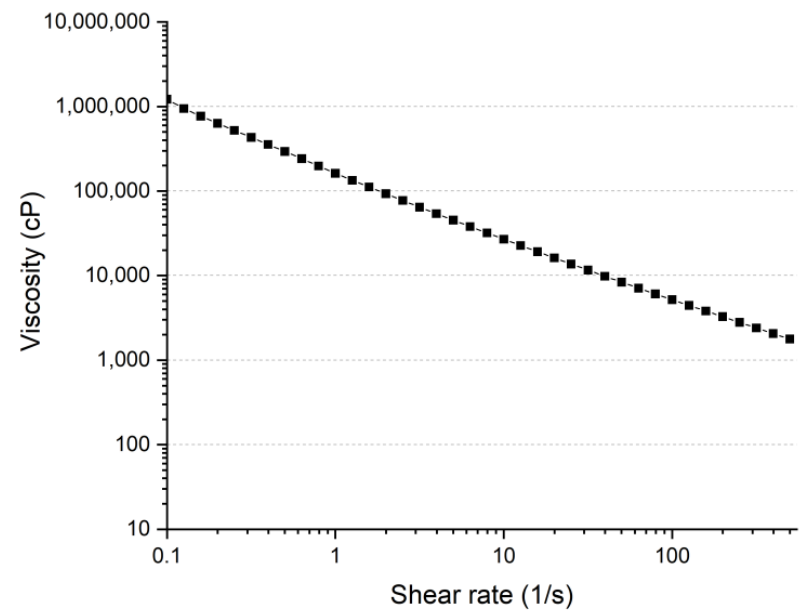
Figure 1. Viscosity of modified Nafion ink as a function of shear rate.